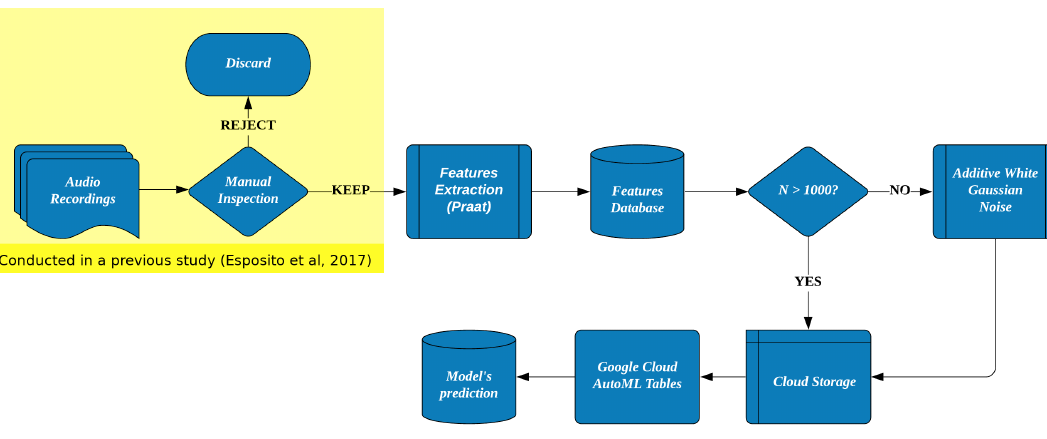
Figure 1. Summary of the steps employed in the development of the model for the diagnosis of Postpartum Depression (PPD) from infants’ cry